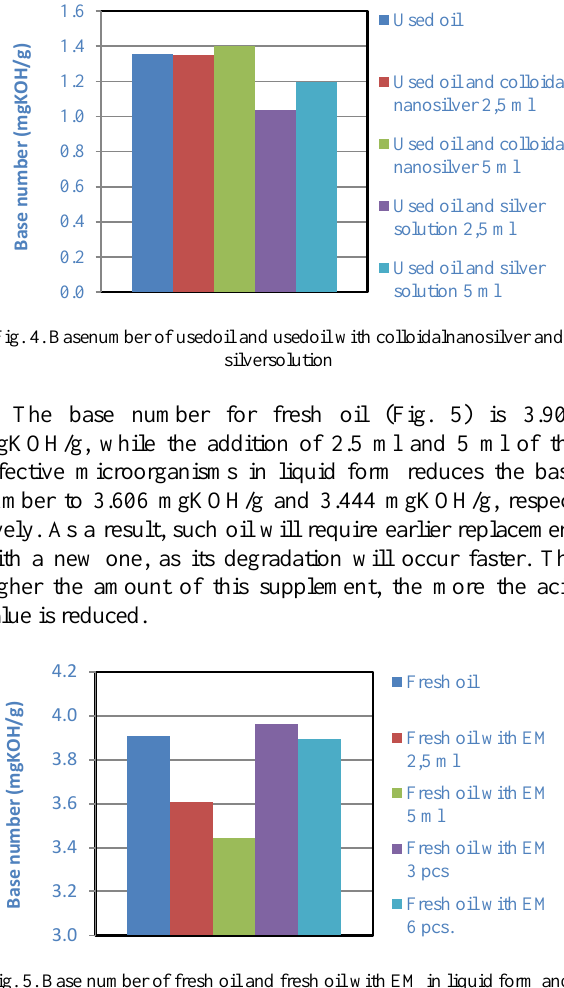
Fig. 5. Base number of fresh oil and fresh oil with EM in liquid form and ceramic